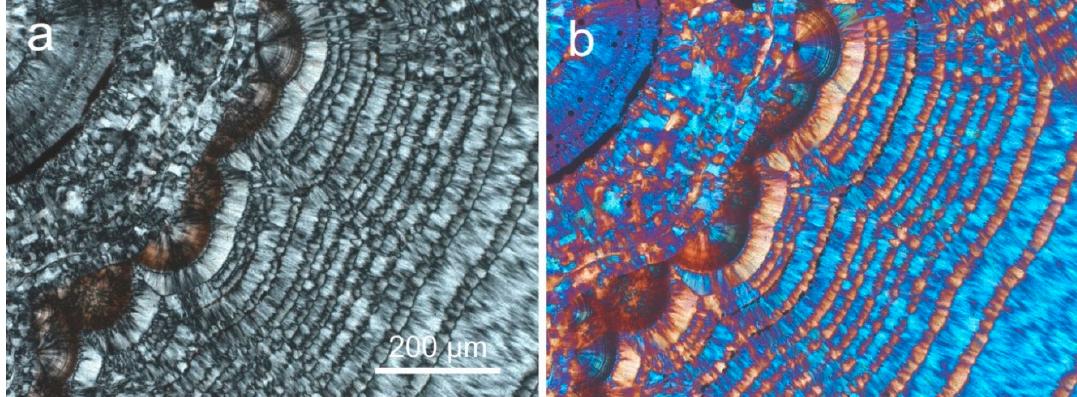
Figure 4. Agate from Xuanhua (Hebei province, China) in transmitted light (crossed polars) ( a ) and with λ compensator ( b ) showing alternating bands of fibrous chalcedony (blue) and quartzine (yellow).